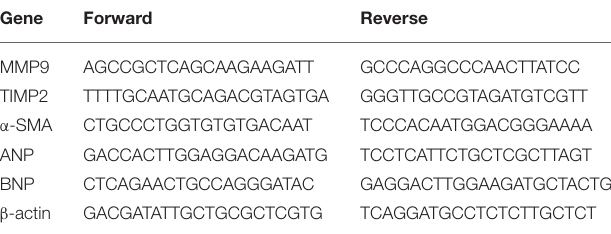
TABLE 1 | RT-qPCR Primers used in this